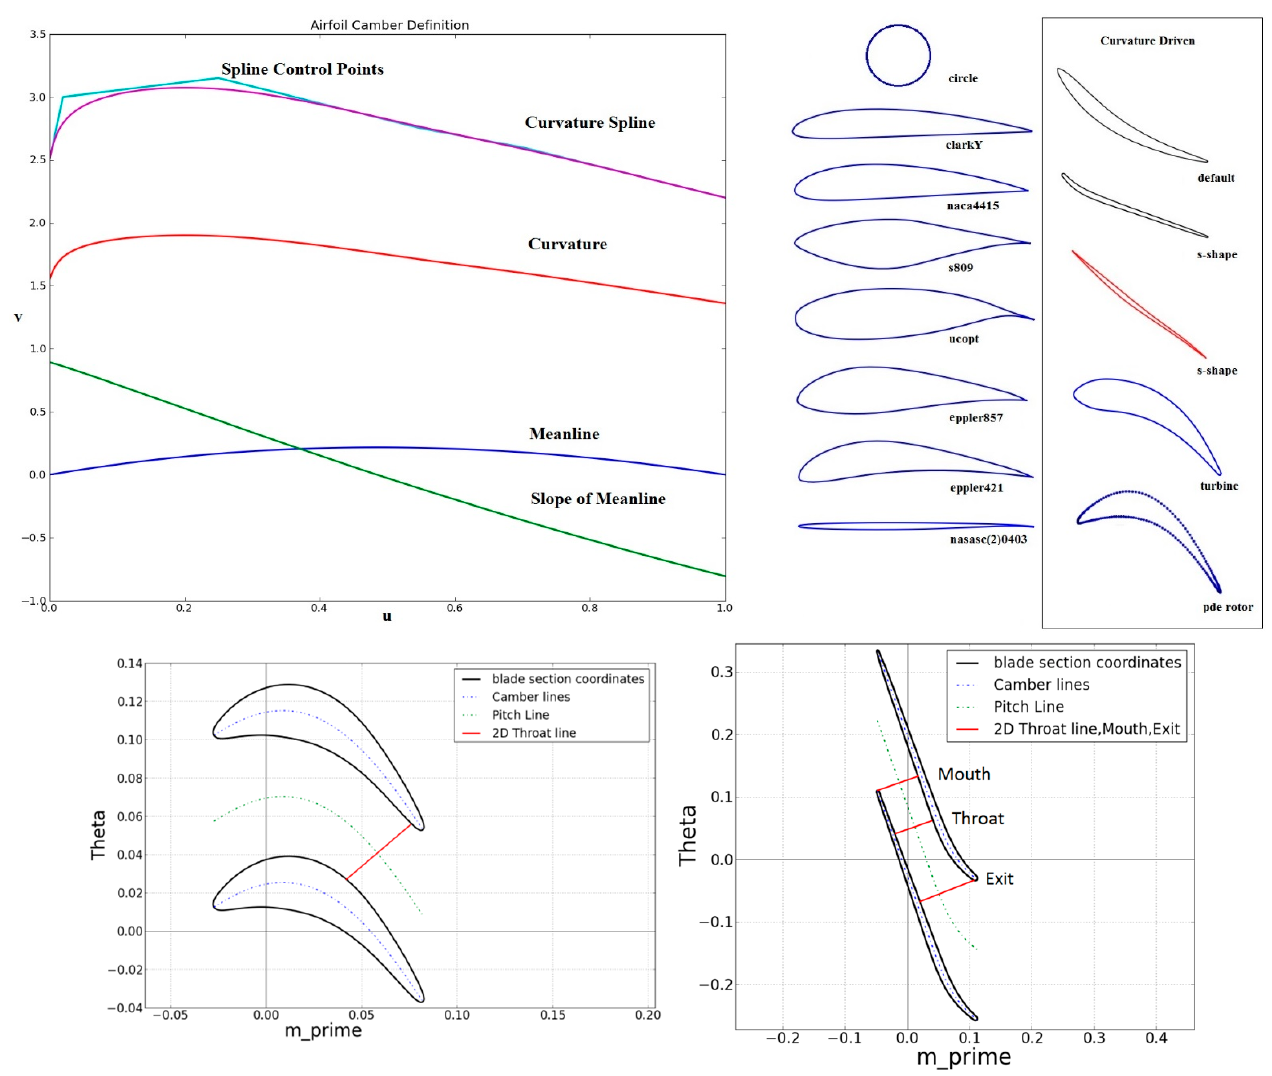
Figure 4. Second derivative cubic B ‐ Spline and meanline in ( u, v ) space. Several 2D airfoils used, either imported or created using curvature driven meanline process. 2D throat for a turbine and a transonic fan rotor cascade.